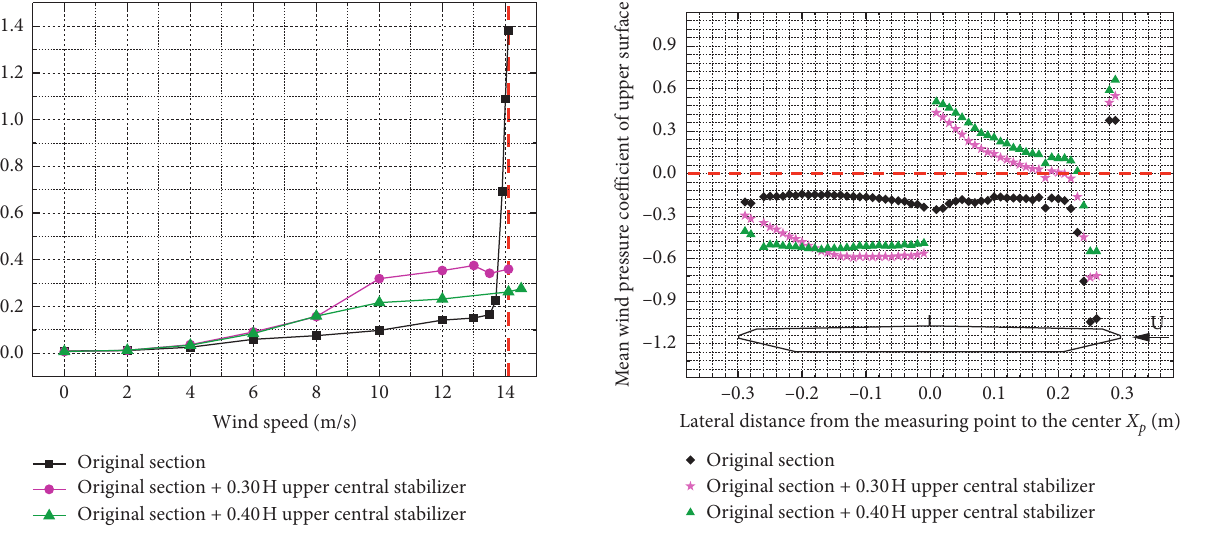
Figure 7: Vertical displacements for different aerodynamic measures.